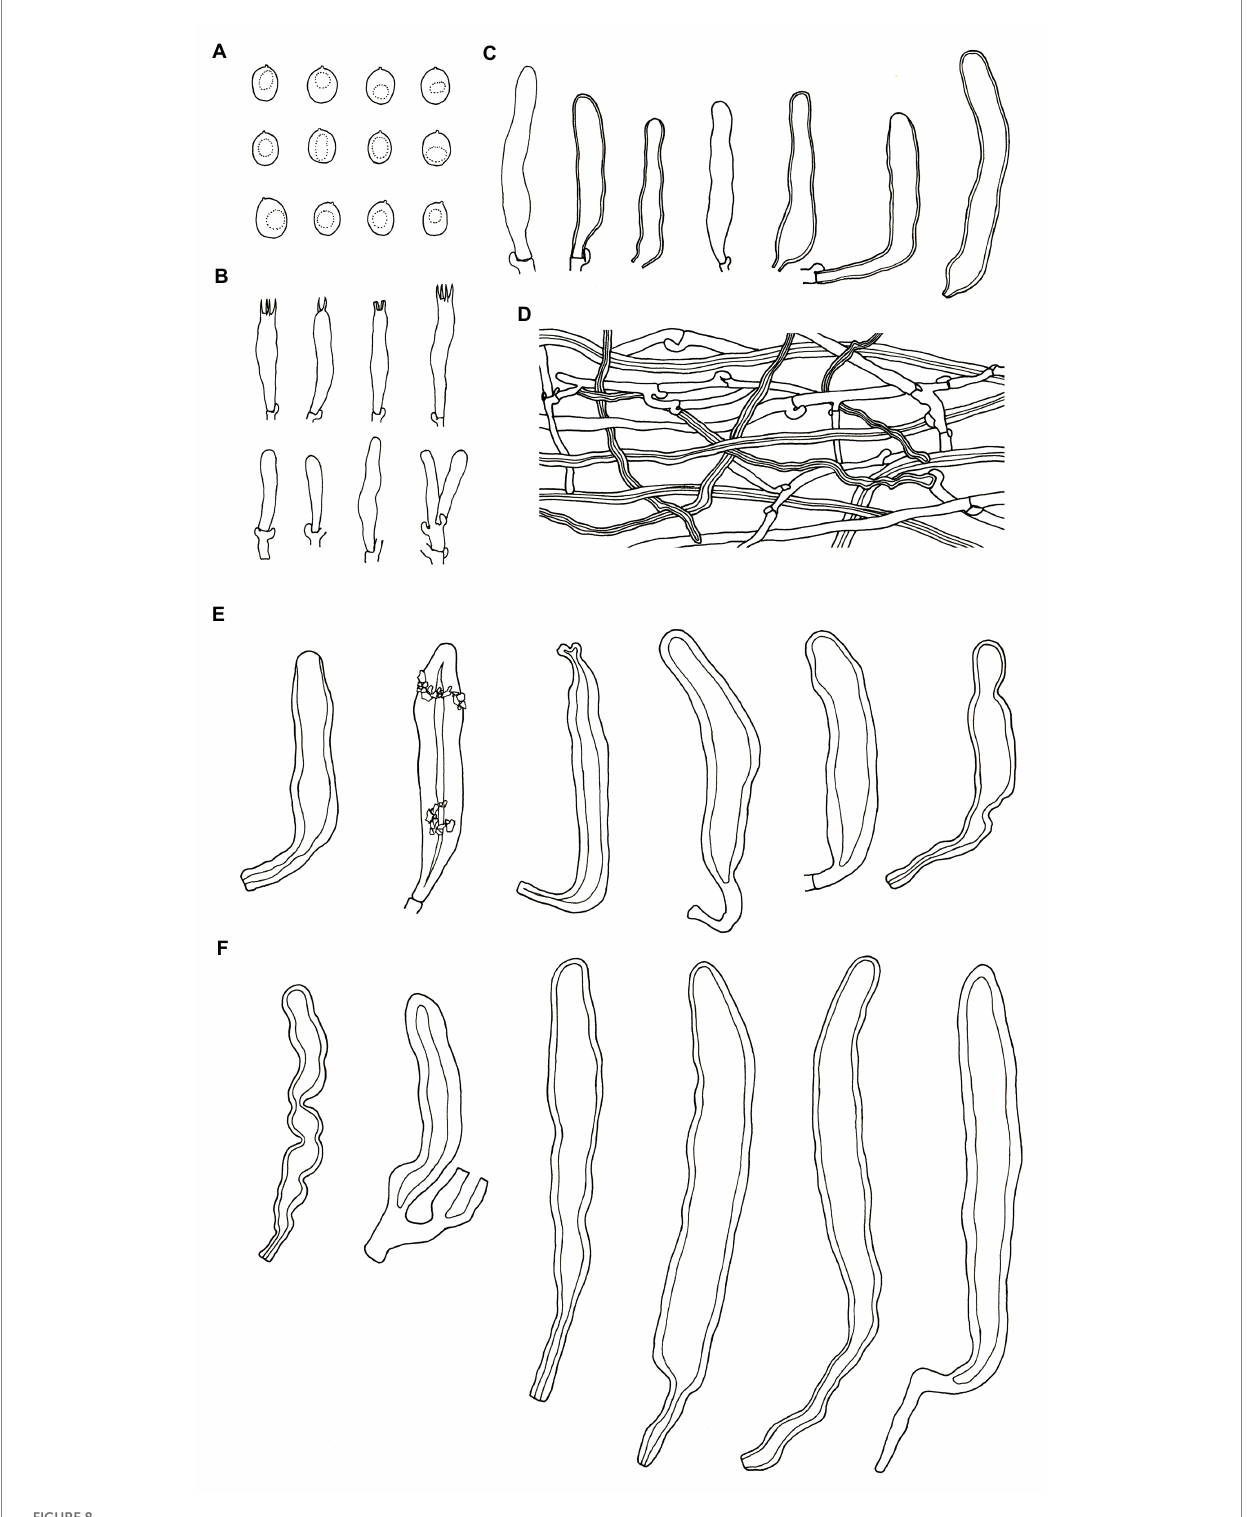
FIGURE 8 Microscopic structures of Podoscypha tropica (140719-19, holotype). (A) Basidiospores, (B) basidia and basidioles, (C) gloeocystidia, (D) hyphae from context, (E) pilocystidia, and (F) caulocystidia. (Bars: (A) = 5 μ m, (B–F) = 10 μ m). Drawn by Hai-Jiao